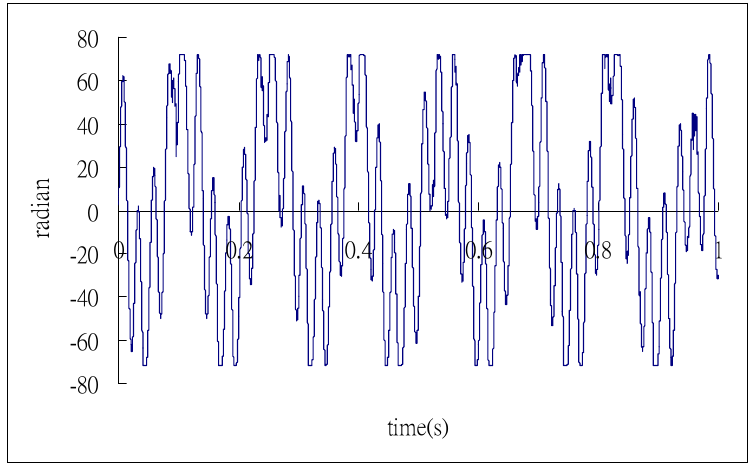
Figure 11. Demodulated phase shift with dual excitation frequencies of 7 Hz and 40